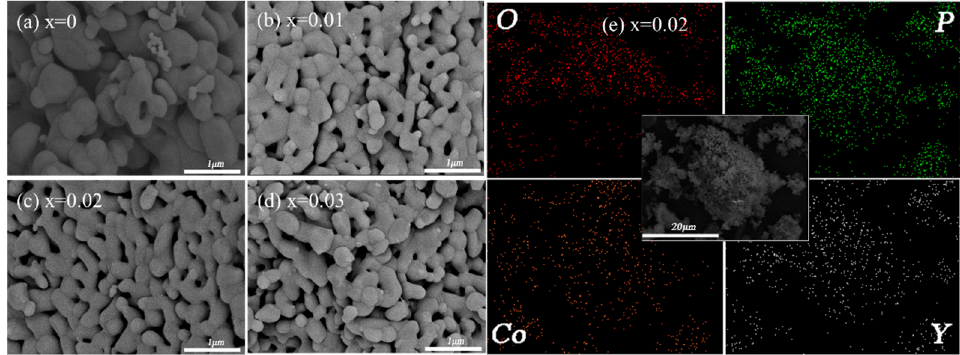
Figure 3. ( a – d ) SEM images of the four cathode materials and ( e ) EDS images of LiCo 0.97 Y 0.02 PO 4 /C cathode materials.